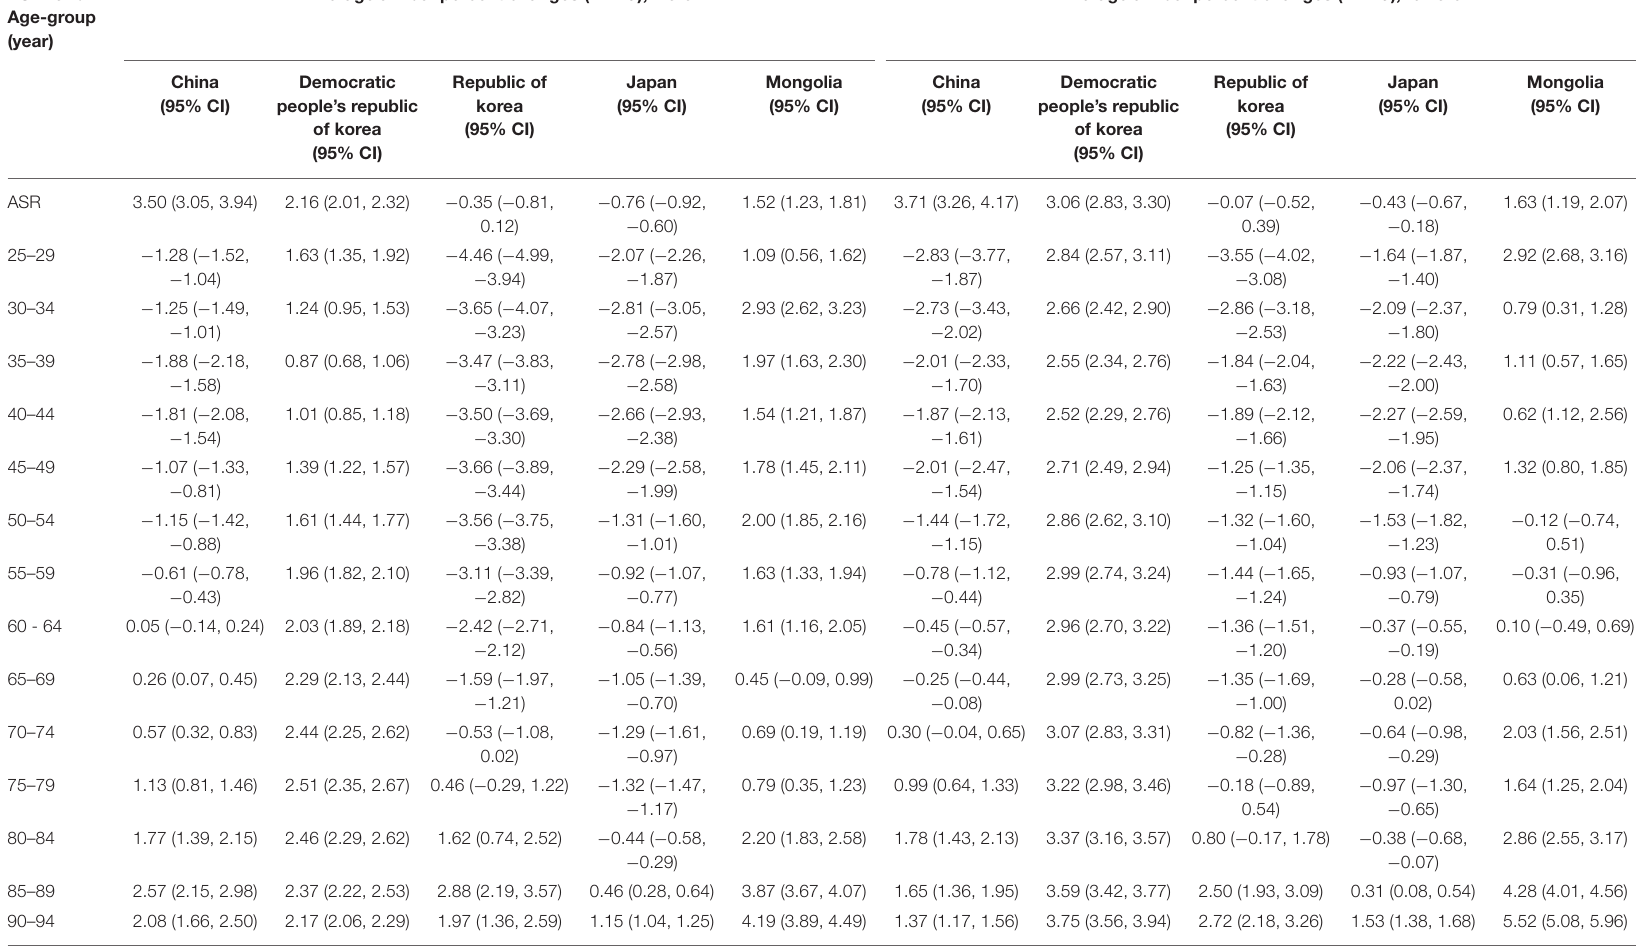
TABLE 2 | The average annual percent changes (AAPC) in lung cancer deaths attributable to PM 2.5 in East Asia during 1990–2019 for male and female patients. ASR* and